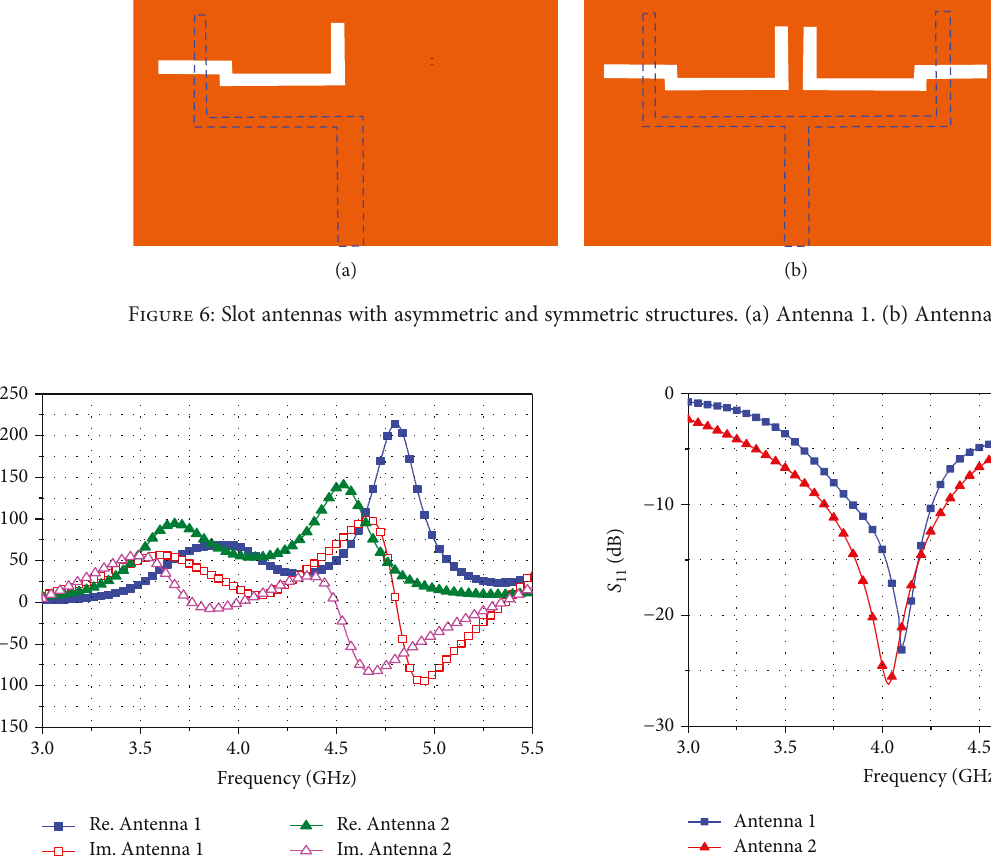
Figure 7: Input impedance of antennas in Figure 6. Figure 8: | S